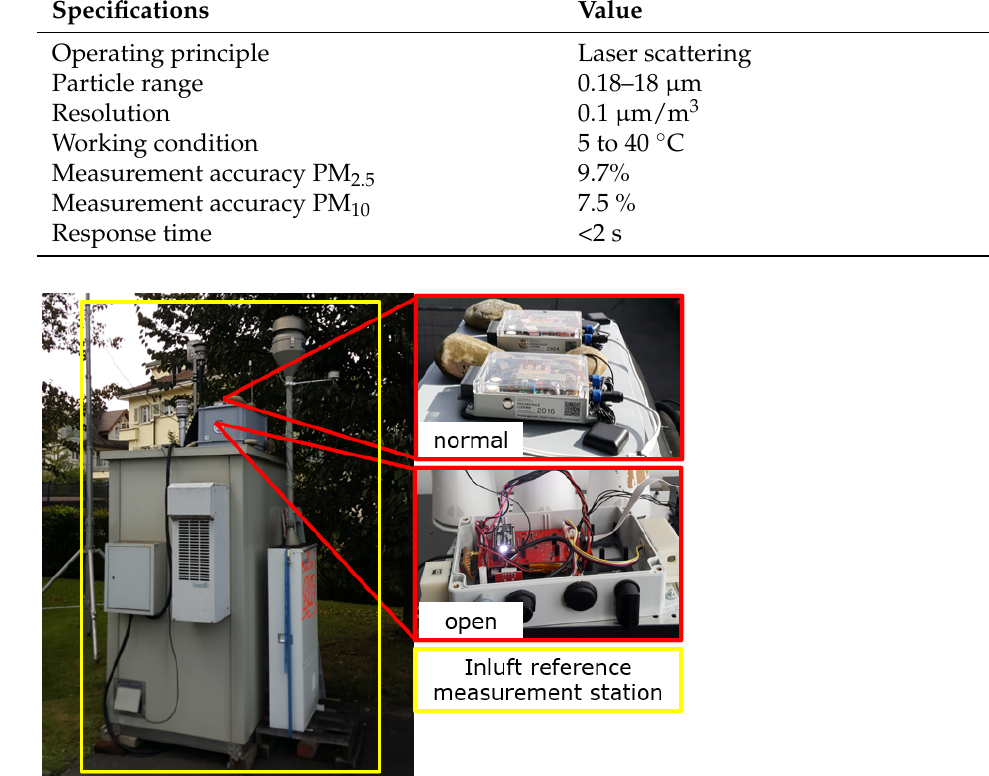
Figure 3. Validation campaign: sensor-boxes with IDs 1, 2 and 7 placed at the in-luft reference station in